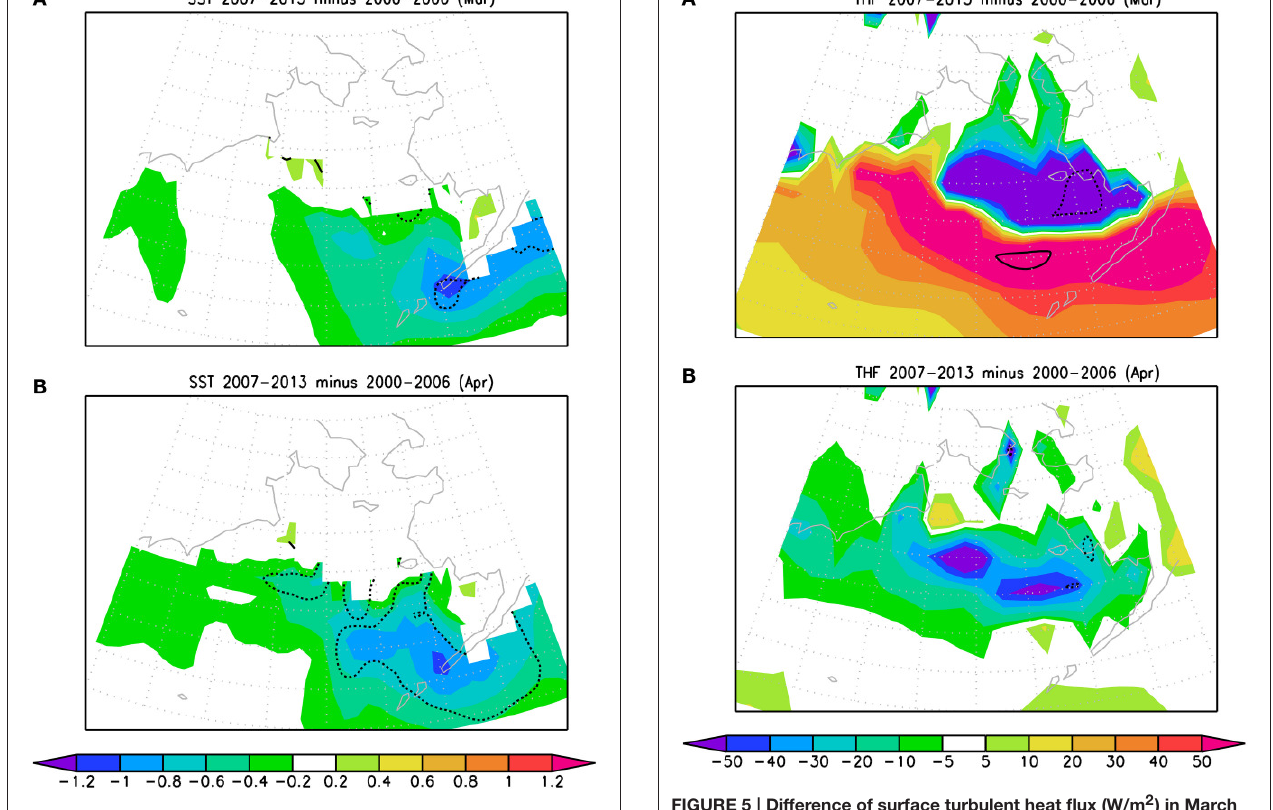
FIGURE 4 | Difference of SST ( ◦ C) in March (A) and April (B) derived as mean during 2007–2013minus that during 2000–2006. The thick lines denote that the difference between 2007–2013 and 2000–2006 is significant at the 99% confidence level according to the Student t -test.